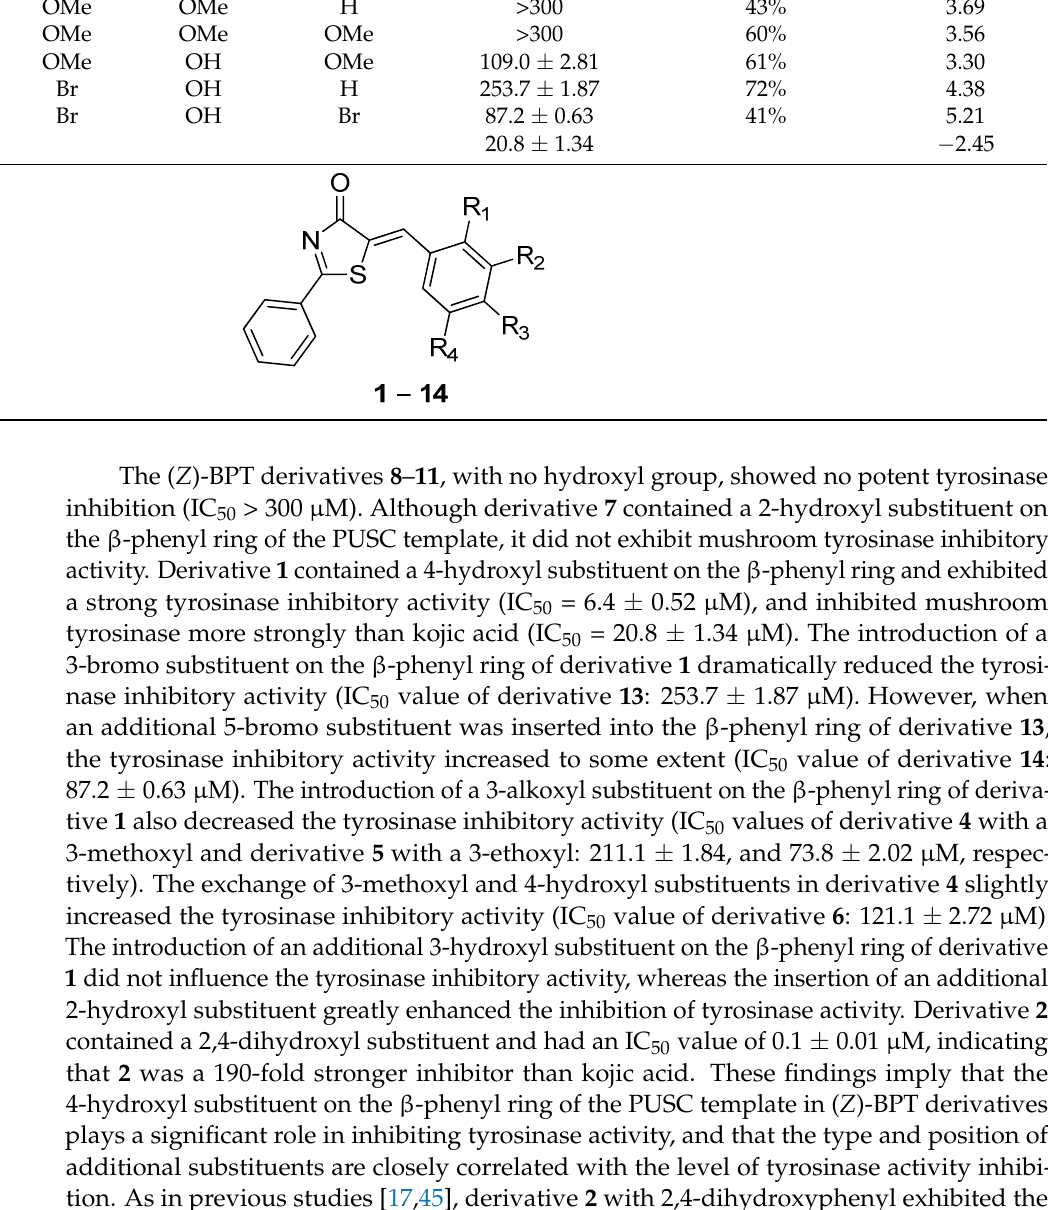
Figure 2. Lineweaver–Burk plots for the inhibition of mushroom tyrosinase activity by ( Z )-BPT de- rivatives 1 – 3 . The inhibition modes of ( Z )-BPT derivatives 1 – 3 were demonstrated by the analysis of Lineweaver–Burk plots. Three independent experiments with five different concentrations (0.5, 1, 2, 4, and 8 mM) of an L -DOPA substrate were used to measure the augmented dopachrome optical density per minute at 492 nm. The data are shown as mean values of 1/V (an inverse of that optical density per minute). The ( Z )-BPT derivatives were used at concentrations of 0 (filled circles), 3 (un- filled circles), 6 (filled triangles), and 12 µM (unfilled triangles) for 1 ; 0 (filled circles), 0.05 (unfilled circles), 0.1 (filled triangles), and 0.2 µM (unfilled triangles) for 2 ; and 0 (filled circles), 2.5 (unfilled circles), 5 (filled triangles), and 10 µM (unfilled triangles) for 3 . Each experiment was run inde- pendently in triplicates.